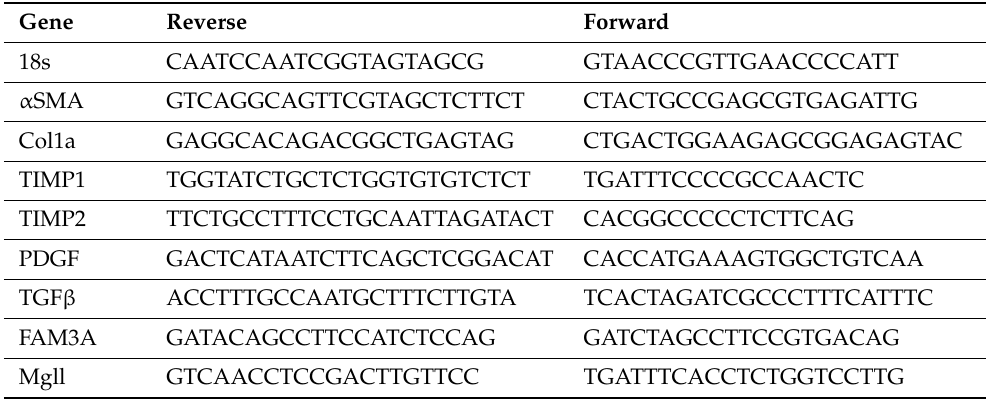
Table 1. Primers used for quantitative real-time